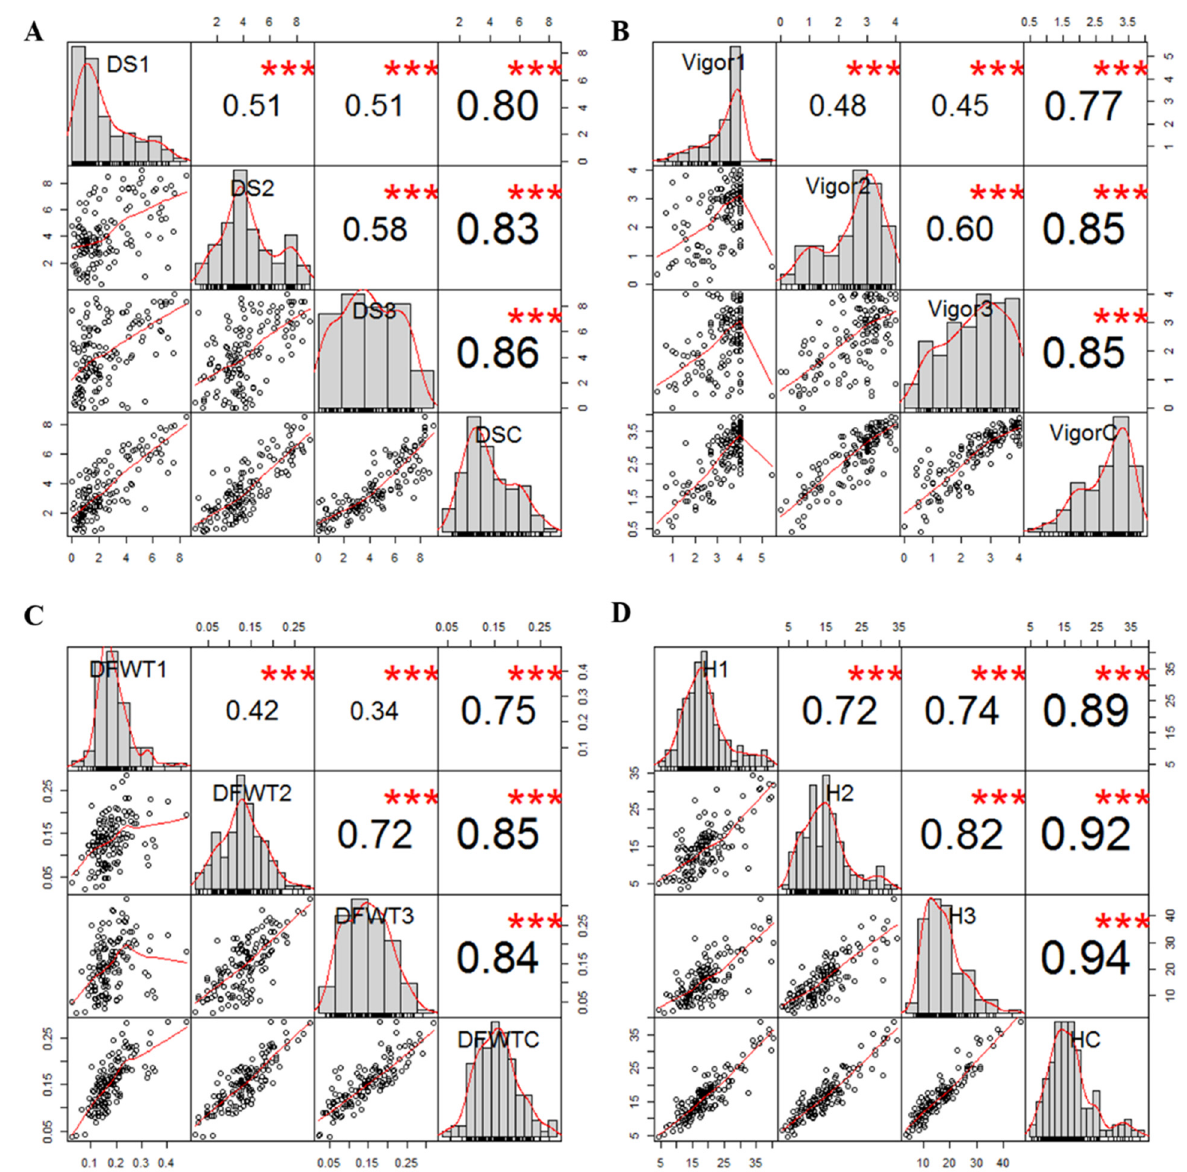
Figure 1. Correlation analysis of estimated mean of three single greenhouse experiments and combined total data for ( A ) root rot severity, ( B ) vigor, ( C ) dry foliar weight and ( D ) height of pea inoculated with Aphanomyces euteiches , illustrating the significant correlation among all variables for each trait. The bar graphs indicate the frequency distributions across the diagonal. The correlation coefficients with a significance level (*** indicates p < 0.001) and scatter plots between pairs are shown above and below the diagonal, respectively.